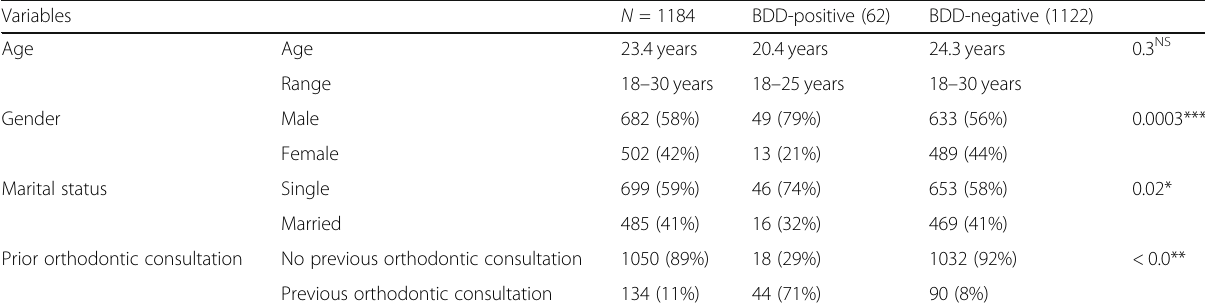
Table 2 Comparison of the questionnaire ’ s items between BDD and non-BDD patients Variables